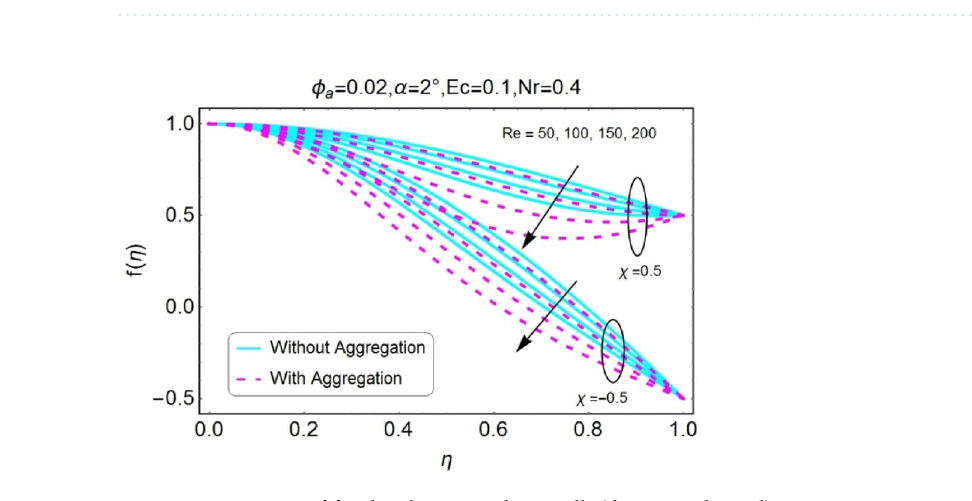
Figure 8. Re varying f for shrinking/stretching walls (divergent channel).